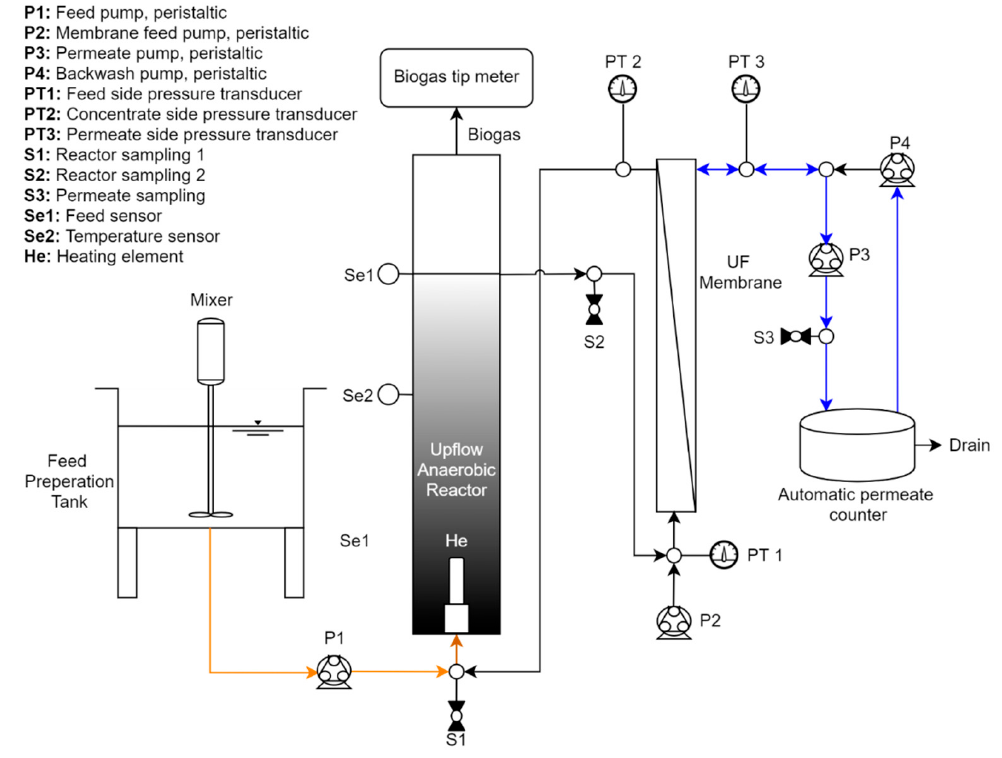
Figure 1. Schematic of the 6.2 L upflow anaerobic membrane